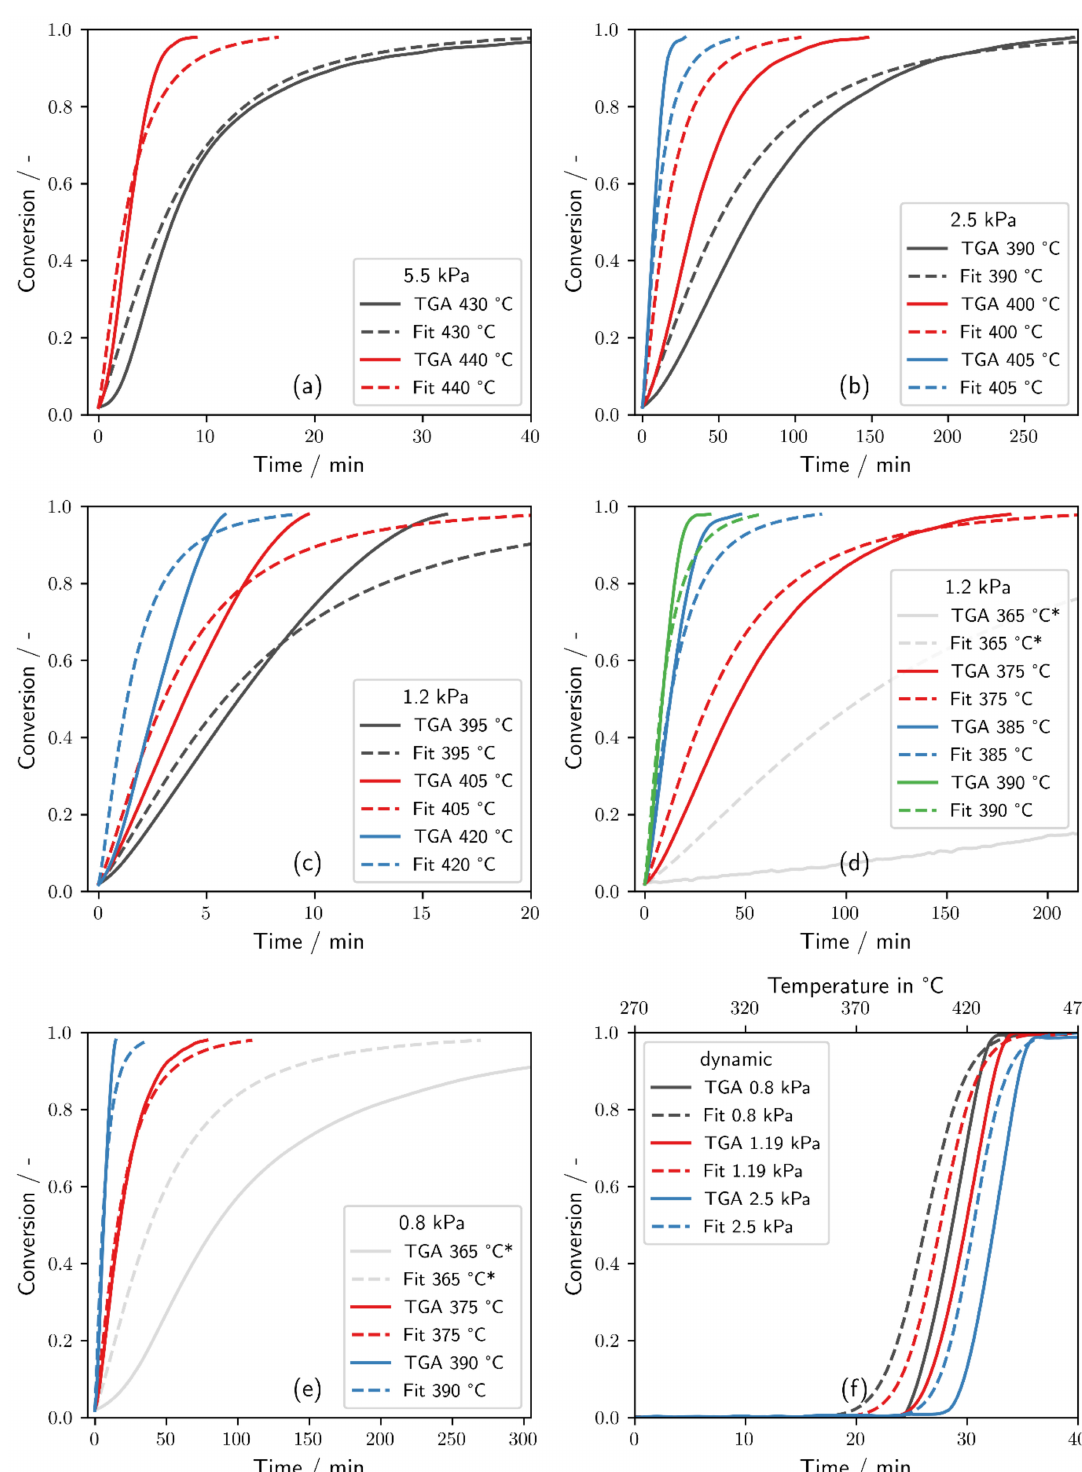
Figure 2. Comparison of the TGA measurements for the dehydration and their respective mathemati- cal fit for different pressures and temperatures ( a – e ) and dynamic measurements ( f ). Entries marked with ‘*’ were not considered for the fitting